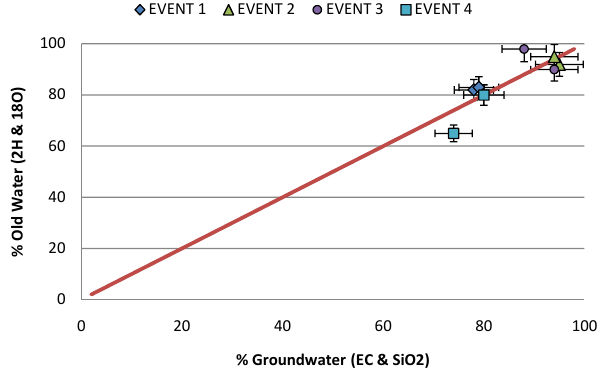
Figure 9. Percentages of groundwater and old water contributions using environmental isotopes ( δ 2 H and δ 18 O) and hydrochemical (EC and SiO 2 ) tracers.